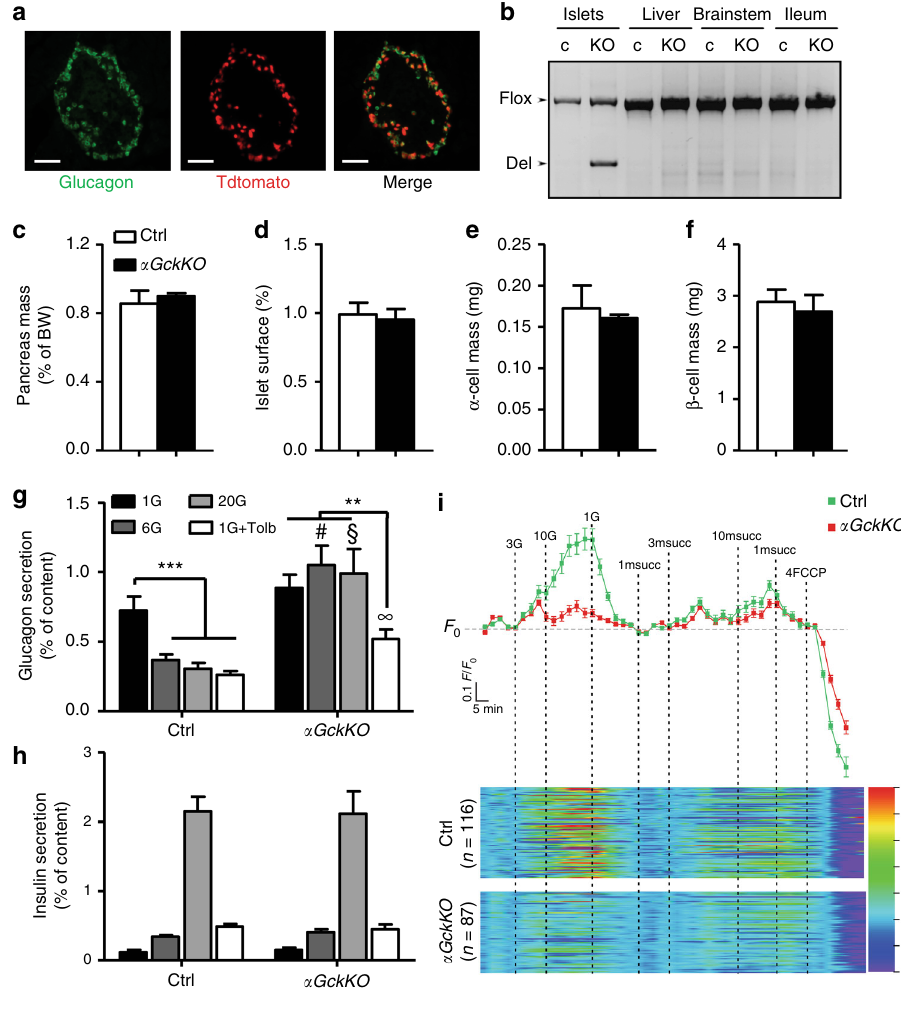
Fig. 1 Alpha-cell Gck inactivation and the suppression of glucagon secretion. a Representative immuno fl uorescence (out of n = 3 replicates) of the co- localization of glucagon (green) and tdtomato (red) in a pancreatic section from α GckKO-Rosa26tdtomato mice. Scale bar: 100 µ m. b PCR analysis of recombination of the Gck fl ox allele in the indicated tissues of Ctrl and α GckKO mice . c Pancreas' weight normalized to BW. See also Supplementary Fig. 1. d Islet surface expressed as percentage of total pancreatic surface. e α -cell mass. f β -cell mass. Values in b – h were extracted from the analysis of three pancreata for each genotype. g Glucagon and h Insulin secretion from isolated islets in the presence of the indicated glucose (G) concentrations and of tolbutamide. g , h Data represent the average of three independent experiments, each performed in duplicates. *** p < 0.001 vs. Ctrl 1G; ** p < 0.01 vs. α GckKO 1G + Tolb. # p < 0.01 vs. Ctrl 6 G. § p < 0.001 vs. Ctrl 20G. ∞ p < 0.05 vs. Ctrl 1G + Tolb. One-way ANOVA for intra-group analysis and Student ’ s t - test for comparison between genotypes. i ATP/ADP ratio measurements in α -cells of Ctrl and α GckKO islets exposed to glucose and methyl-succinate (msucc). n = 116 for Ctrl and n = 86 for α GckKO α -cells. See also Supplementary Figs. 2 and 3. Data are represented as mean ±